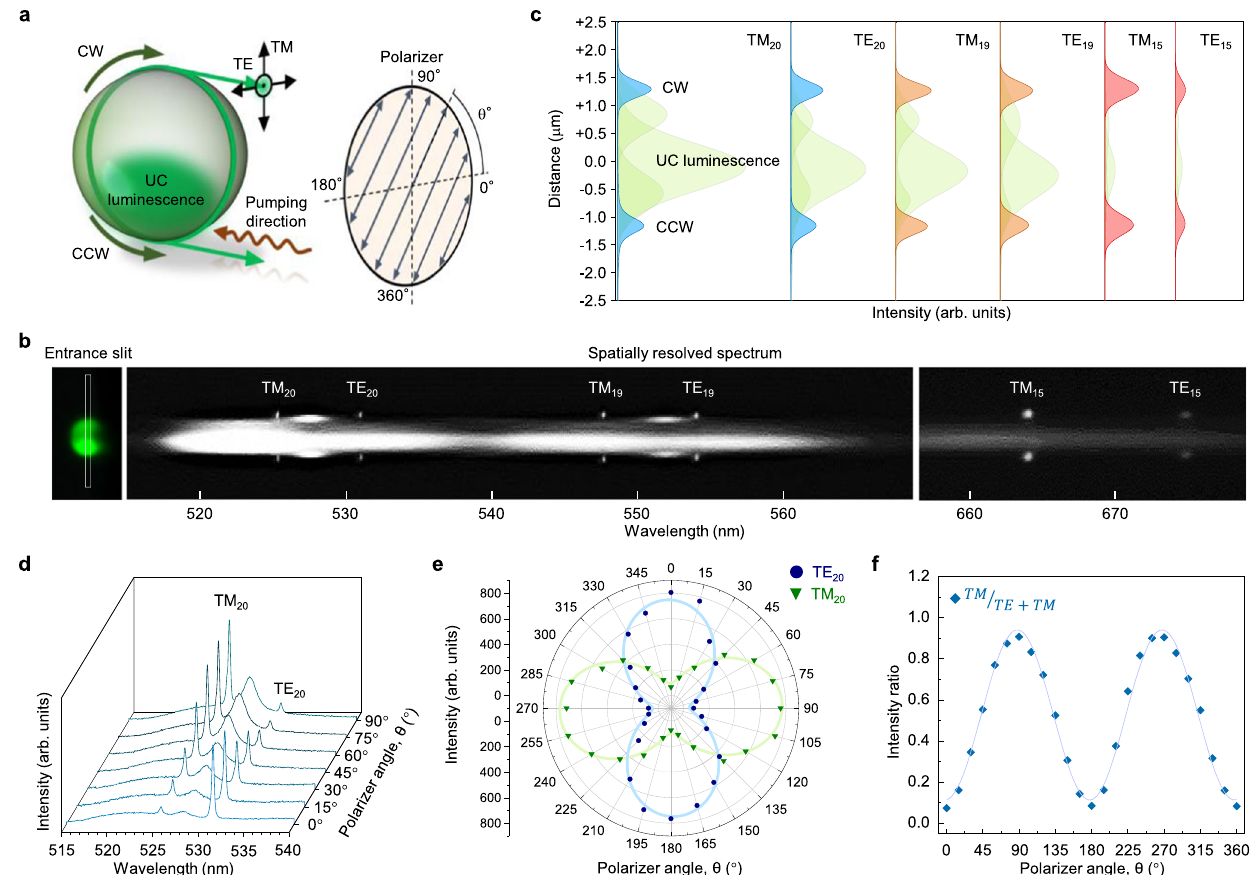
Fig. 4 Spatial, spectral, and polarization analysis of laser emission. a Schematic of WGM analysis in an LQUM determined by circulation direction (clockwise (CW) and counterclockwise (CCW)) and transverse modes (transverse magnetic (TM) and transverse electric (TE) modes). b Spatially resolved spectrum of laser emission from the LQUM. The narrow rectangular section was spatially selected by the spectrograph ’ s entrance slit of 2 μ m and resolved using a high-resolution grating of 1200 lines mm − 1 (centered at 500 nm). Along with vertical direction, each point of the selected area generates emission spectrum horizontally on the panel of EMCCD to create the image of b . c Deconvolution of the laser lines using Gaussian-Lorentz fi tting. d – f Polarization investigation of the laser lines using the emission spectrum ( d ), a polar plot of the intensities ( e ) and the intensity ratio ( f ). The fi tting curves in e and f were drawn by a cosine-square